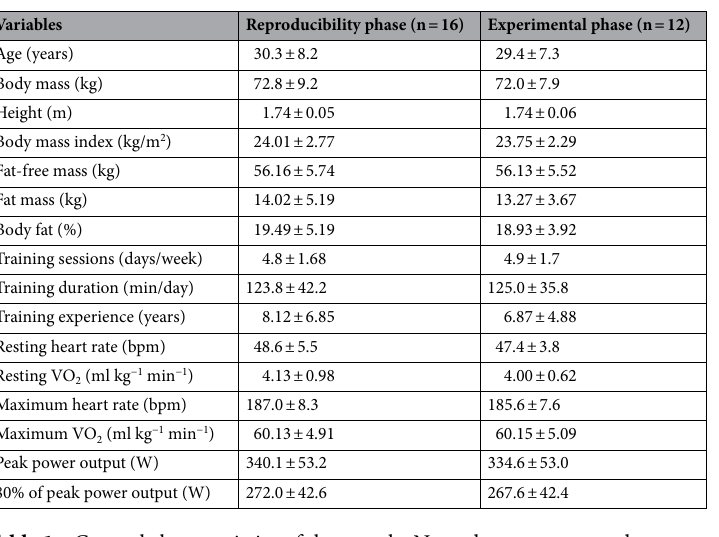
Table 1. General characteristics of the sample. Note: data are presented as mean ± standard deviation; VO 2 = oxygen